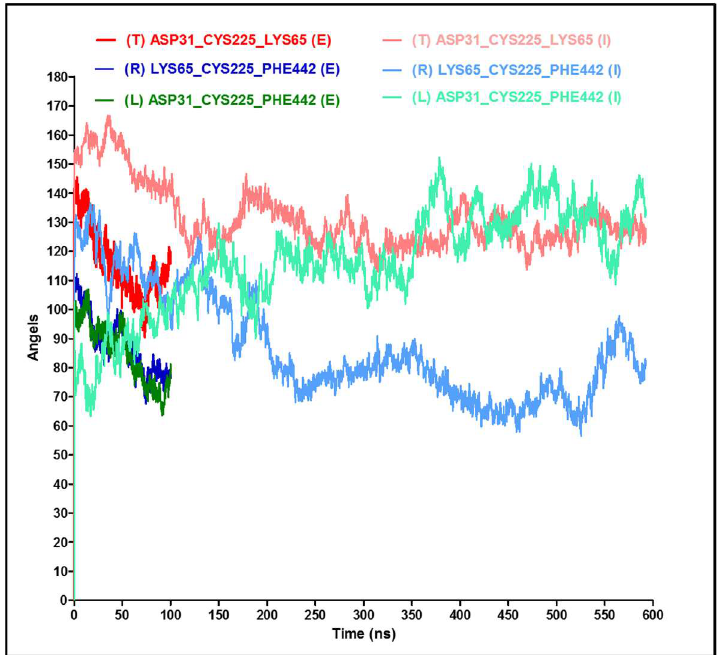
Figure 8. Angle extrapolation between implicit and explicit systems. Time values were corrected for the implicit system through multiplying by a conversion factor of 6.